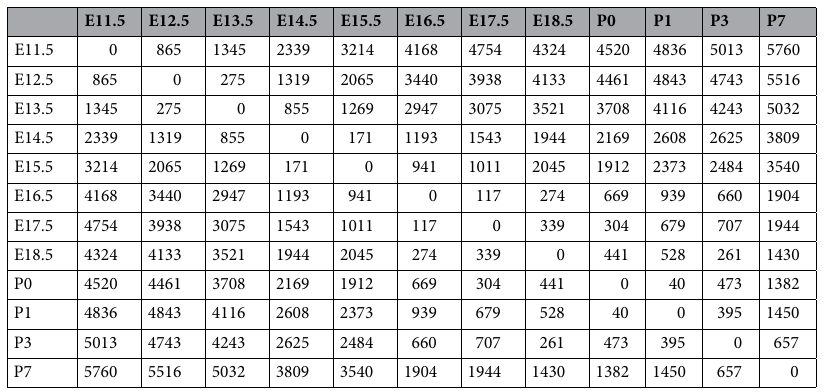
Table 1. Pairwise different expression analysis.